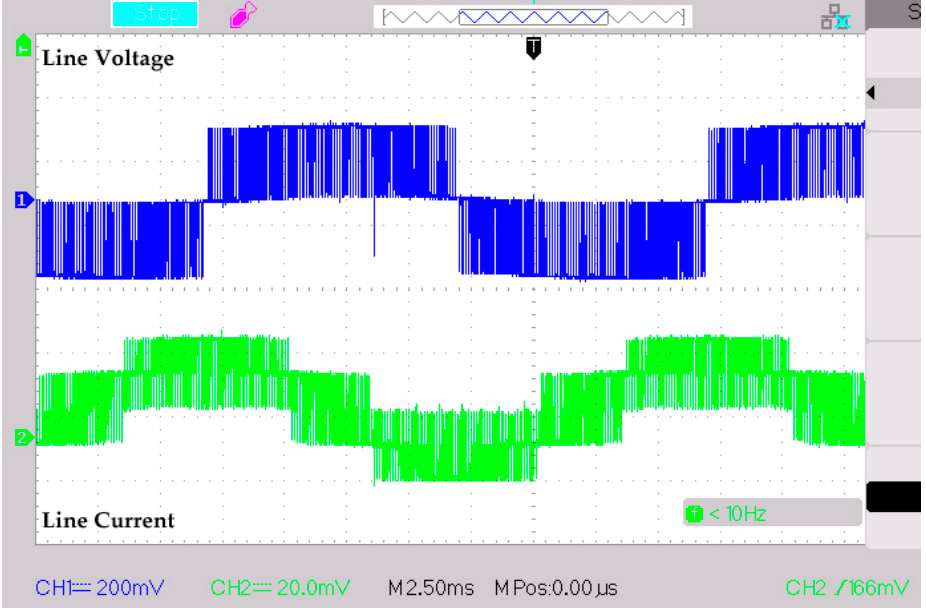
Figure 33. Line voltage and current at inverter output.